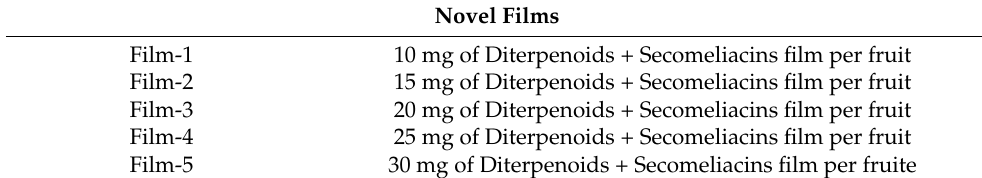
Table 1. The design of new five films developed.